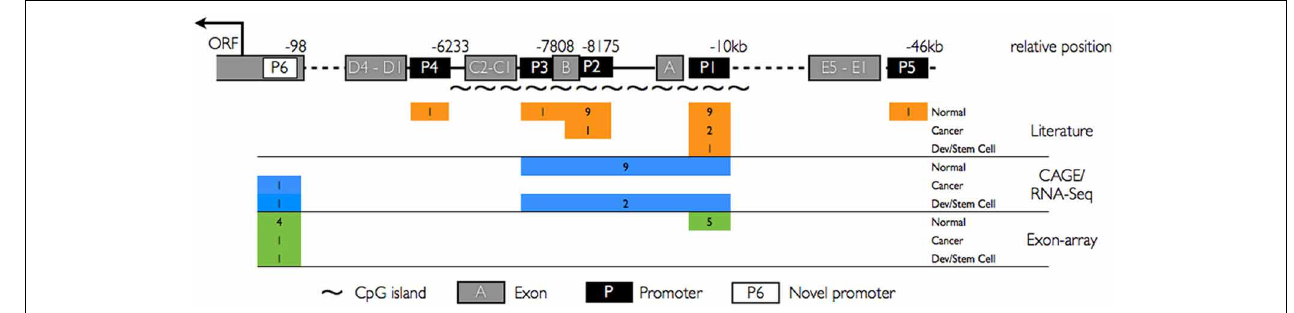
and developmental systems/stem cells as captured by different platforms. Orange: known promoter activities reported in the literature based on single gene studies. Blue: CAGE and RNA seq studies. Green: Affymetrix exon array exome expression. Promoters P1–P3 are widely expressed in the literature and using CAGE and RNA-seq assay. P6 is not yet reported in the literature.